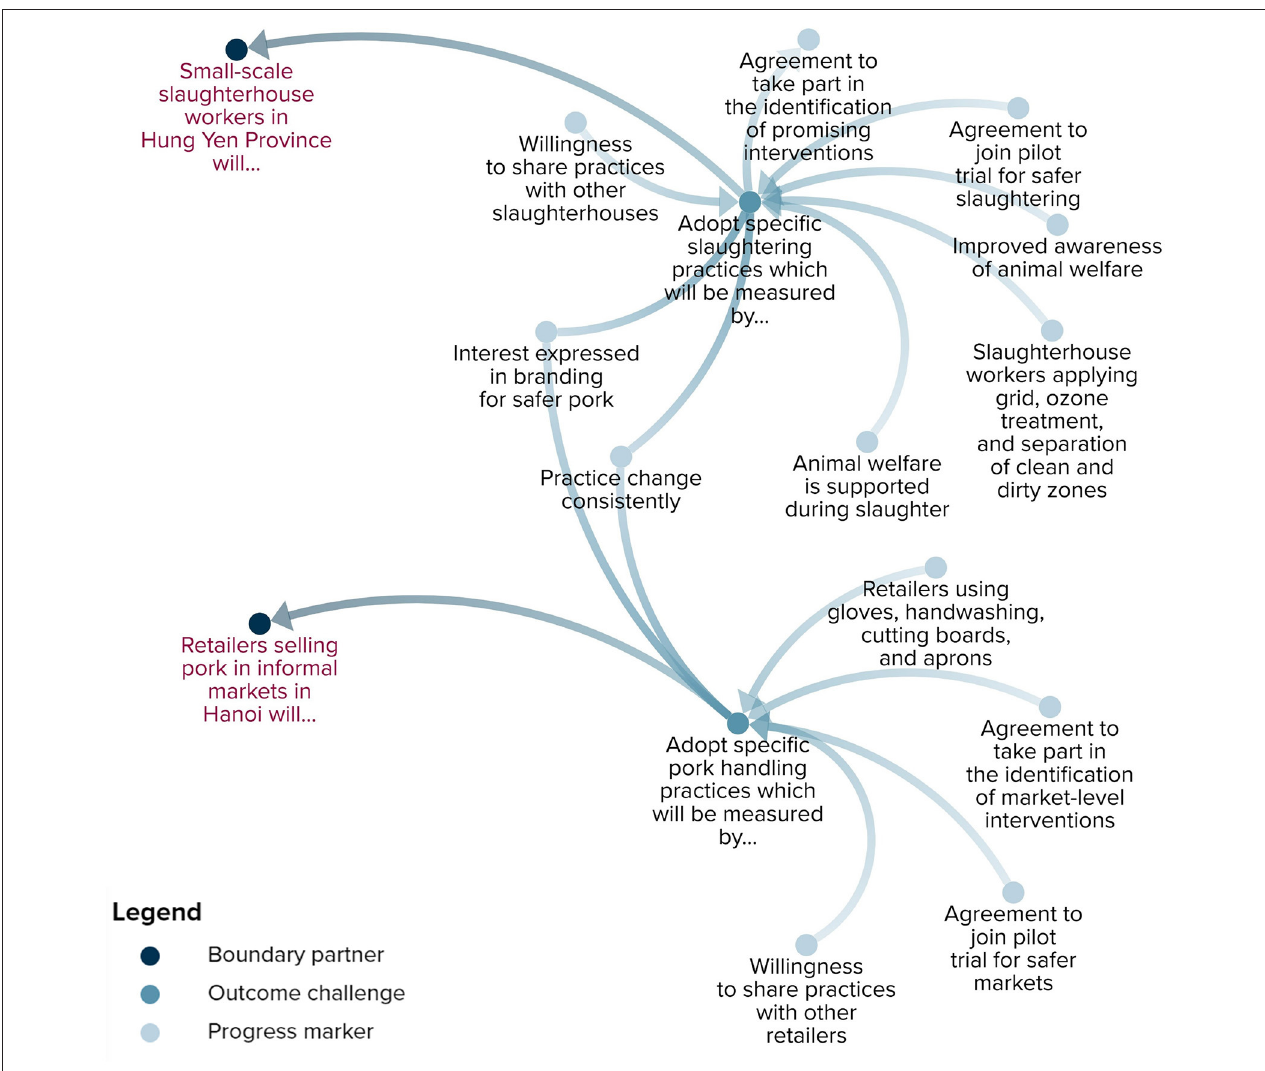
FIGURE 4 | Boundary partners, outcome challenges, and progress markers of